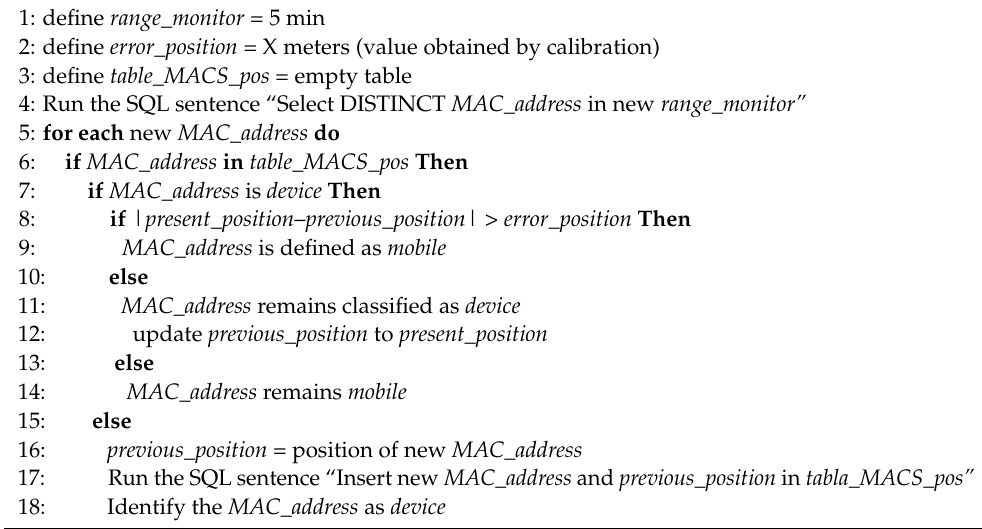
Algorithm 1 . Process to differentiate mobile and static devices with a Wi-Fi